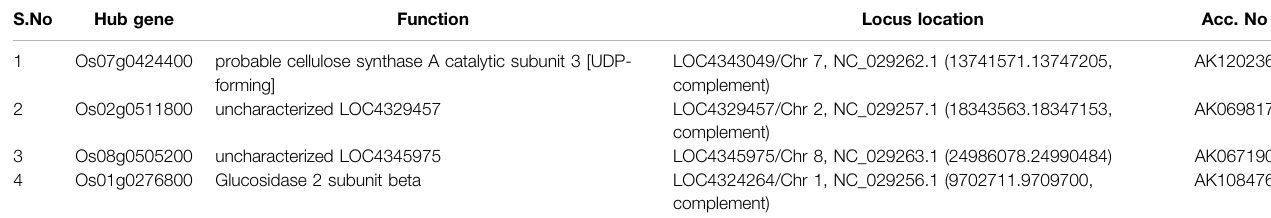
TABLE 2 | Identi fi ed hub genes with respect to their level of connectivity in the blue